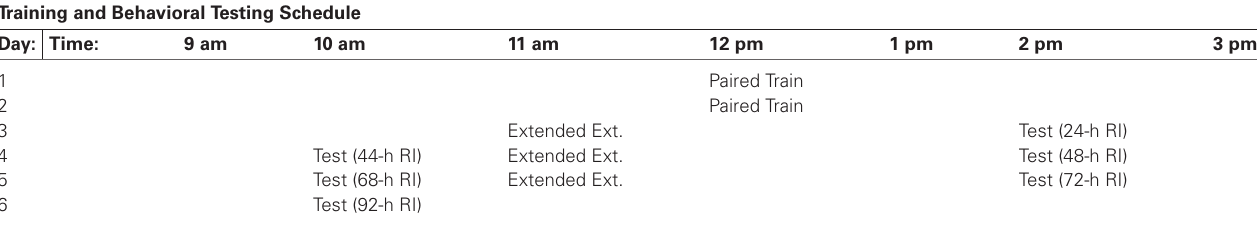
Table 1 | Training and behavioral testing (Test) schedule for animals given delayed (24 h) extended extinction training (Extended Ext.) that comprised three sessions of 50 light-alone presentations . Training and Behavioral Testing